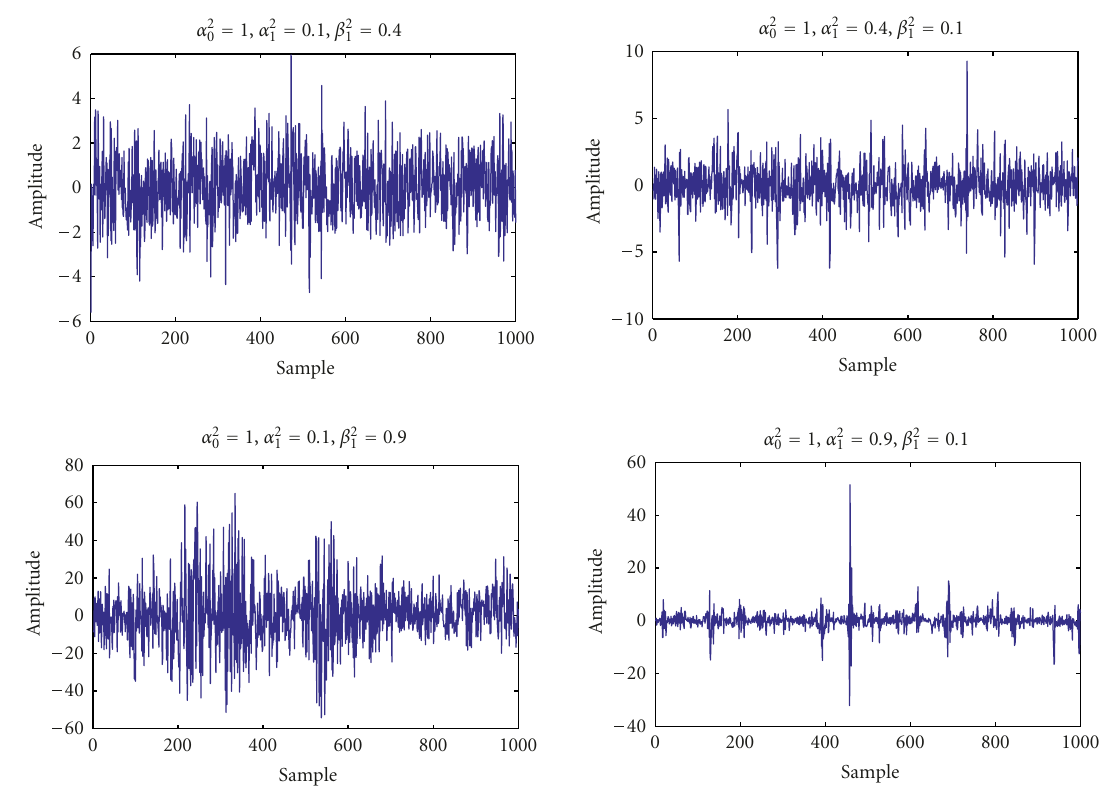
Figure 1: Some realizations of the GARCH(1,1) with di ff erent coe ffi cients.